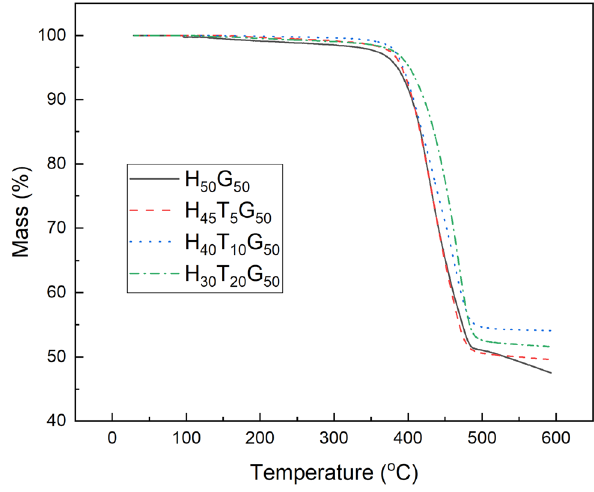
Figure 8: Thermogravimetric curves of H 50 G 50 , H 45 T 5 G 50 , H 40 T 10 G 50 , and H 30 T 20 G 50